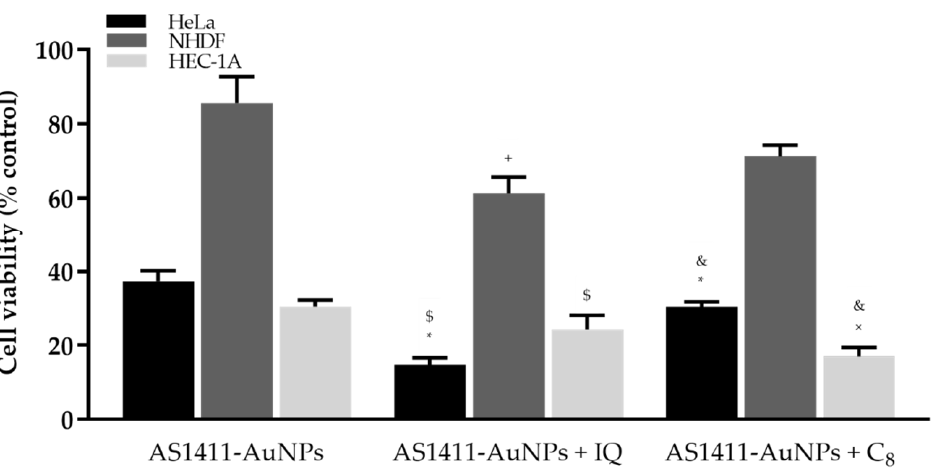
Figure 9. Percentage of viable HeLa, HEC-1-A and NHDF cells after incubation with AS1411-gold nanoparticles (AS1411- nanoparticles (AS1411-AuNPs) (15 µ M), AS1411-AuNPs with IQ (15:5) or AS1411-AuNPs with C 8 AuNPs) (15 µM), AS1411-AuNPs with IQ (15:5) or AS1411-AuNPs with C 8 (15:1) for 3 days. * p < 0.05 relative to AS1411- (15:1) for 3 days. * p < 0.05 relative to AS1411-AuNPs in HeLa cells; $ p < 0.05 relative to AuNPs in HeLa cells; $ p < 0.05 relative to AS1411-AuNPs with IQ in NHDF cells; + p < 0.05 relative to AS1411-AuNPs in NHDF cells; & p < 0.05 relative to AS1411-AuNPs with C 8 in NHDF cells; × p < 0.05 relative to AS1411-AuNPs in HEC-1-A cells.